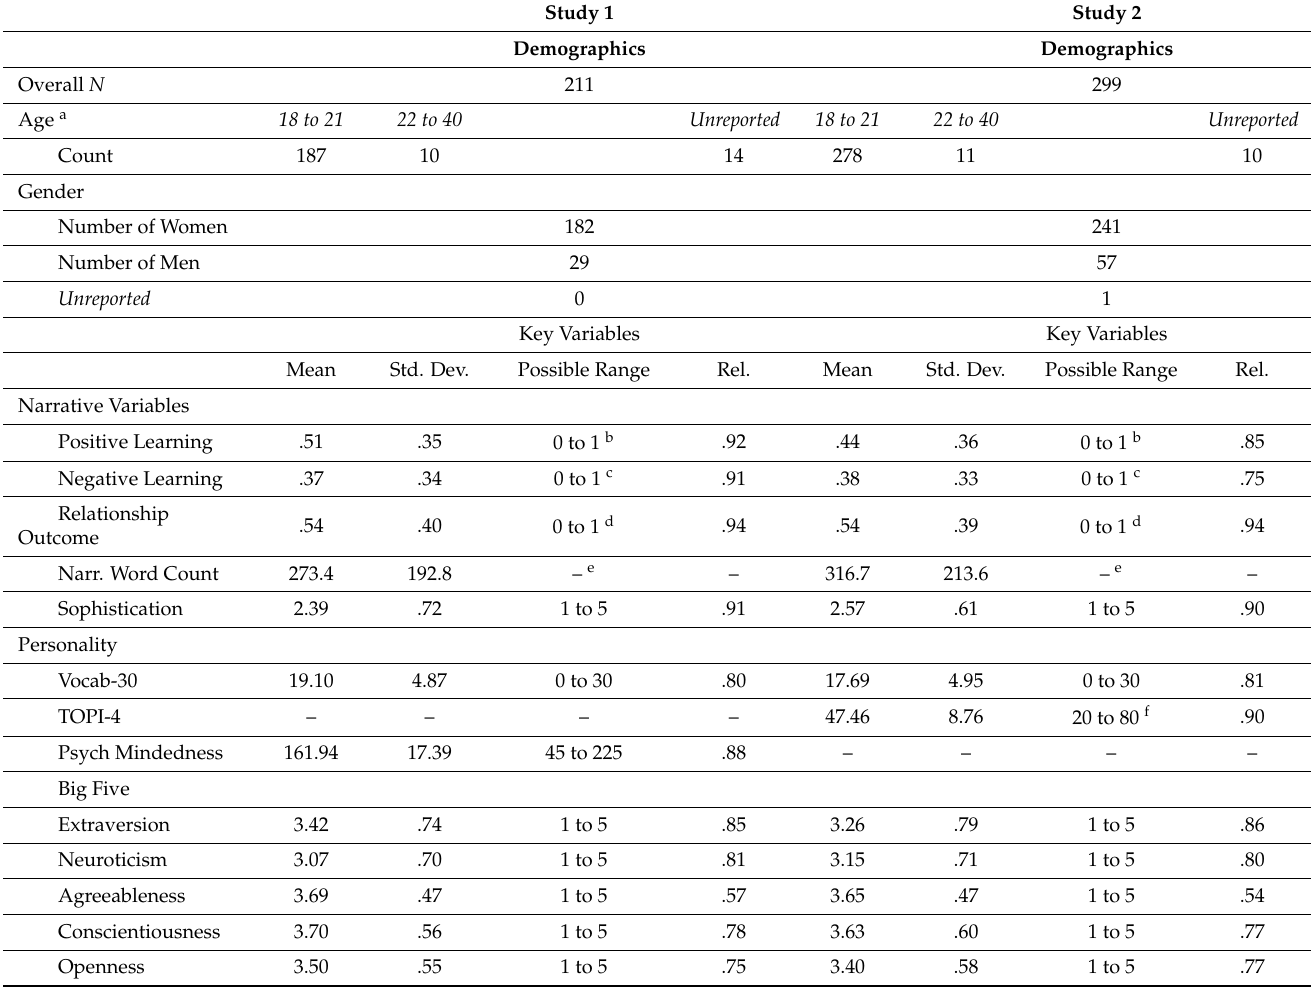
Table 2. Descriptive Statistics for the Central Measures of Studies 1 and